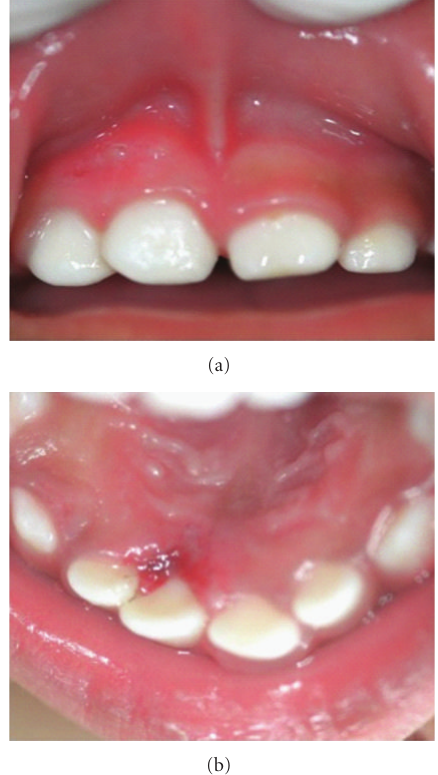
Figure 3: One-week postoperative